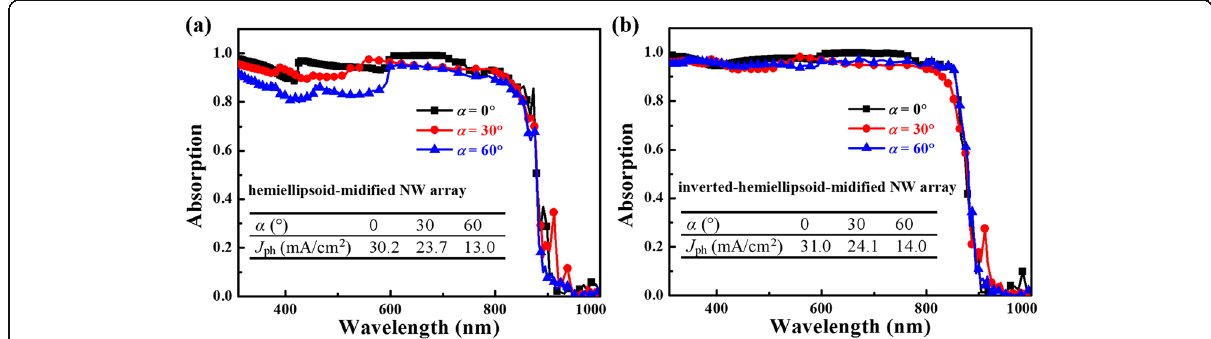
Fig. 5 Absorption spectra of the a hemiellipsoid- and b inverted hemiellipsoid-modified GaAs NW arrays ( H =2000 nm, D =500 nm, and h =500 nm) at the incident angle ( α ) of 0, 30, and 60°. The inset tables summarize the theoretical photocurrent density ( J ph ) for these two top-modified NW arrays at the corresponding incident angles,